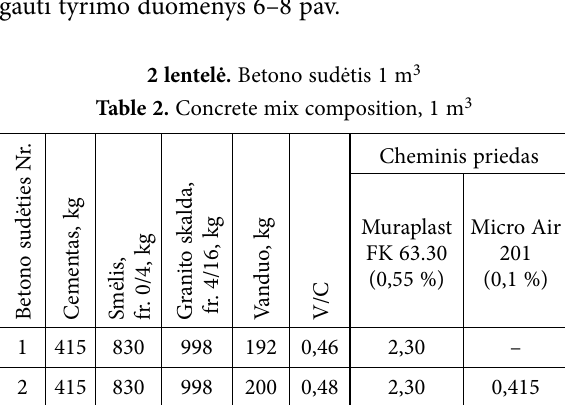
Fig. 7. Dependence of parameters governing concreting process and time (the second concrete